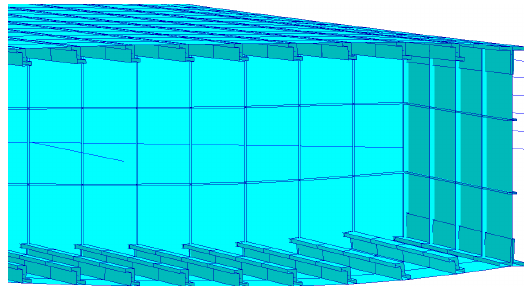
Figure 3. Exemplary detail view of a wing box structure model.